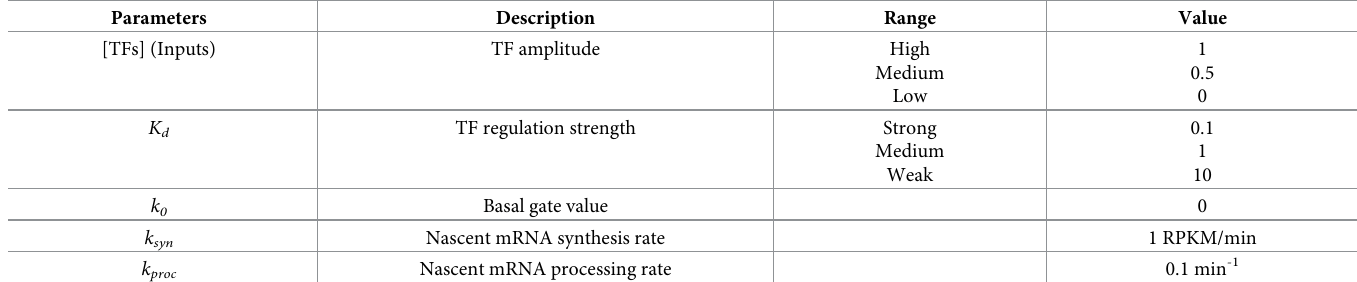
Table 1. Model Parameters.